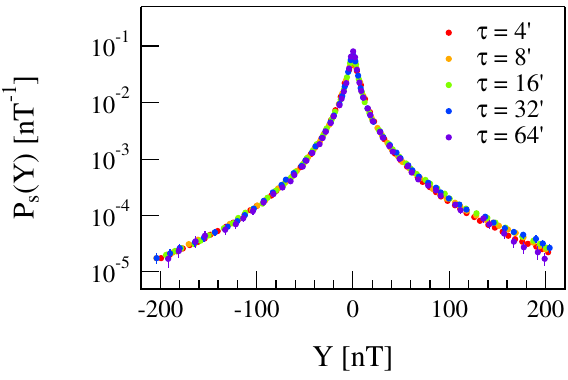
Fig. 8. Collapsing of PDFs using the discrete rank-ordered spectrum s ( Y ) of Figure 7.